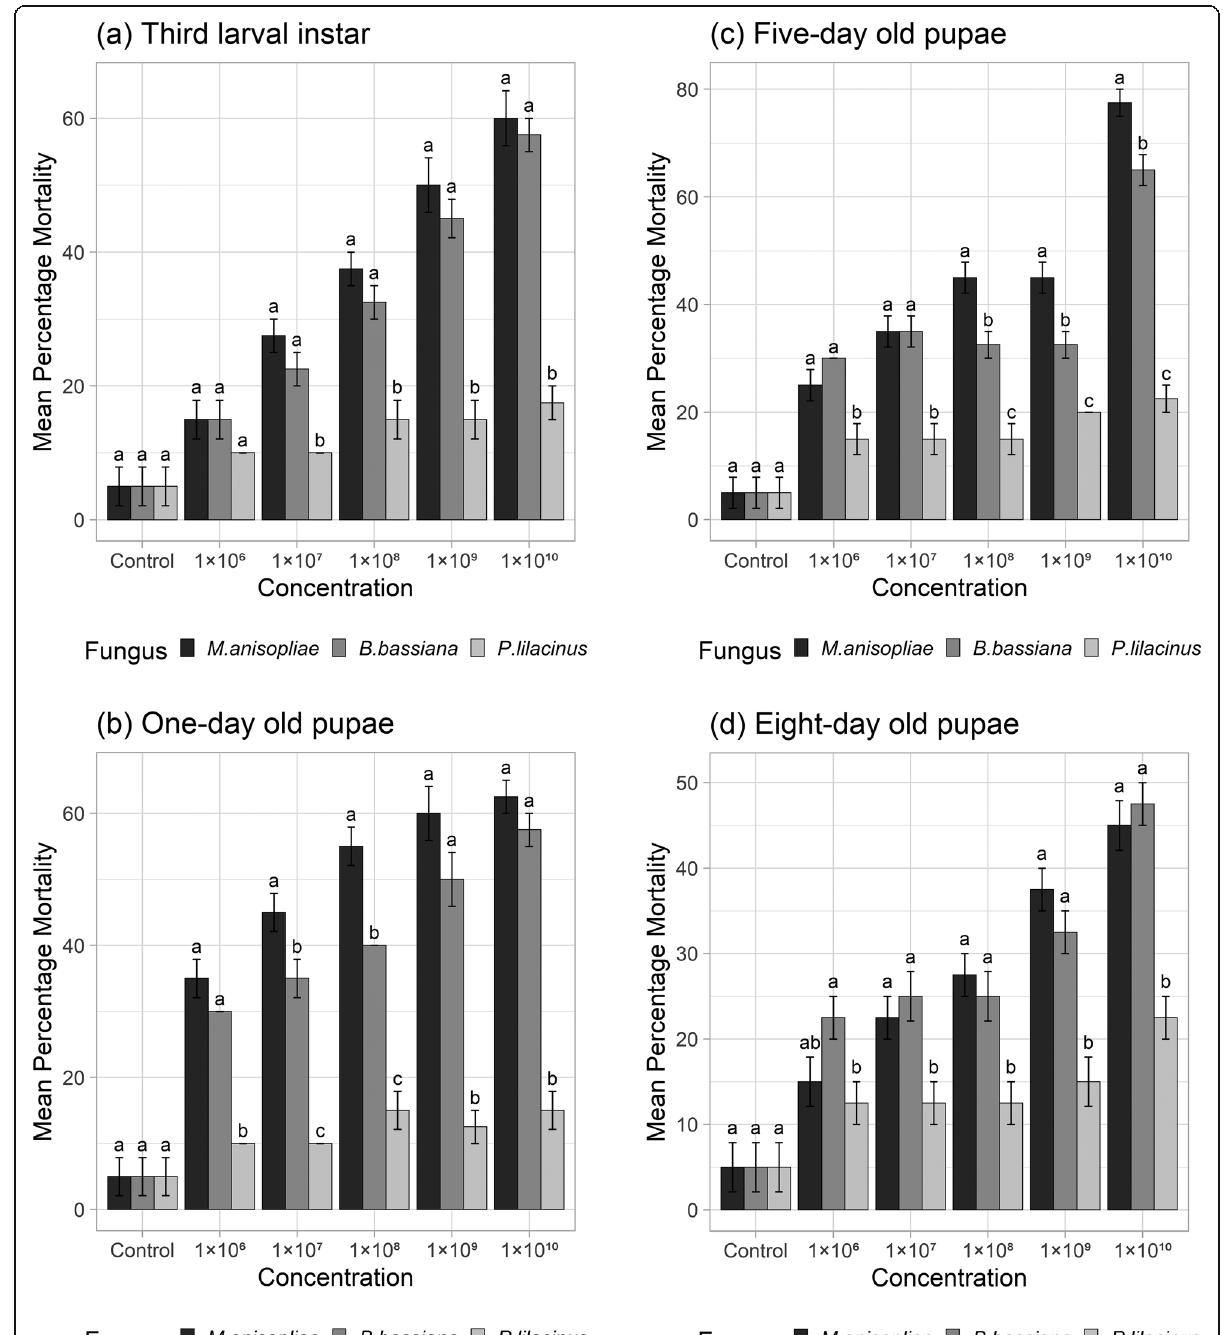
Fig. 1 Mean percentage mortality (%±SD) in immature stages of Ceratitis capitata treated with different concentrations of Metarhizium anisopliae , Beauveria bassiana , and Paecilomyces lilacinus . a Late third larval instar. b 1-day-old pupae. c 5-day-old pupae. d 8-day-old pupae. Bars with the same letter are not significantly different at p >